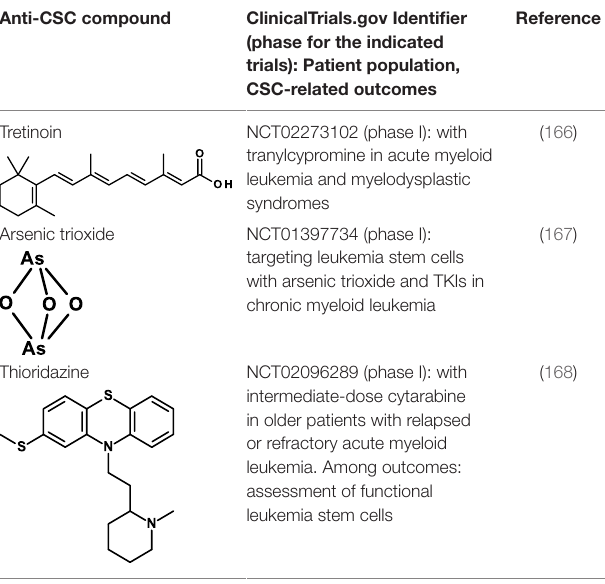
TABLe 4 | inducers of CSC differentiation. Anti-CSC compound ClinicalTrials.gov identifier (phase for the indicated trials): Patient population, CSC-related